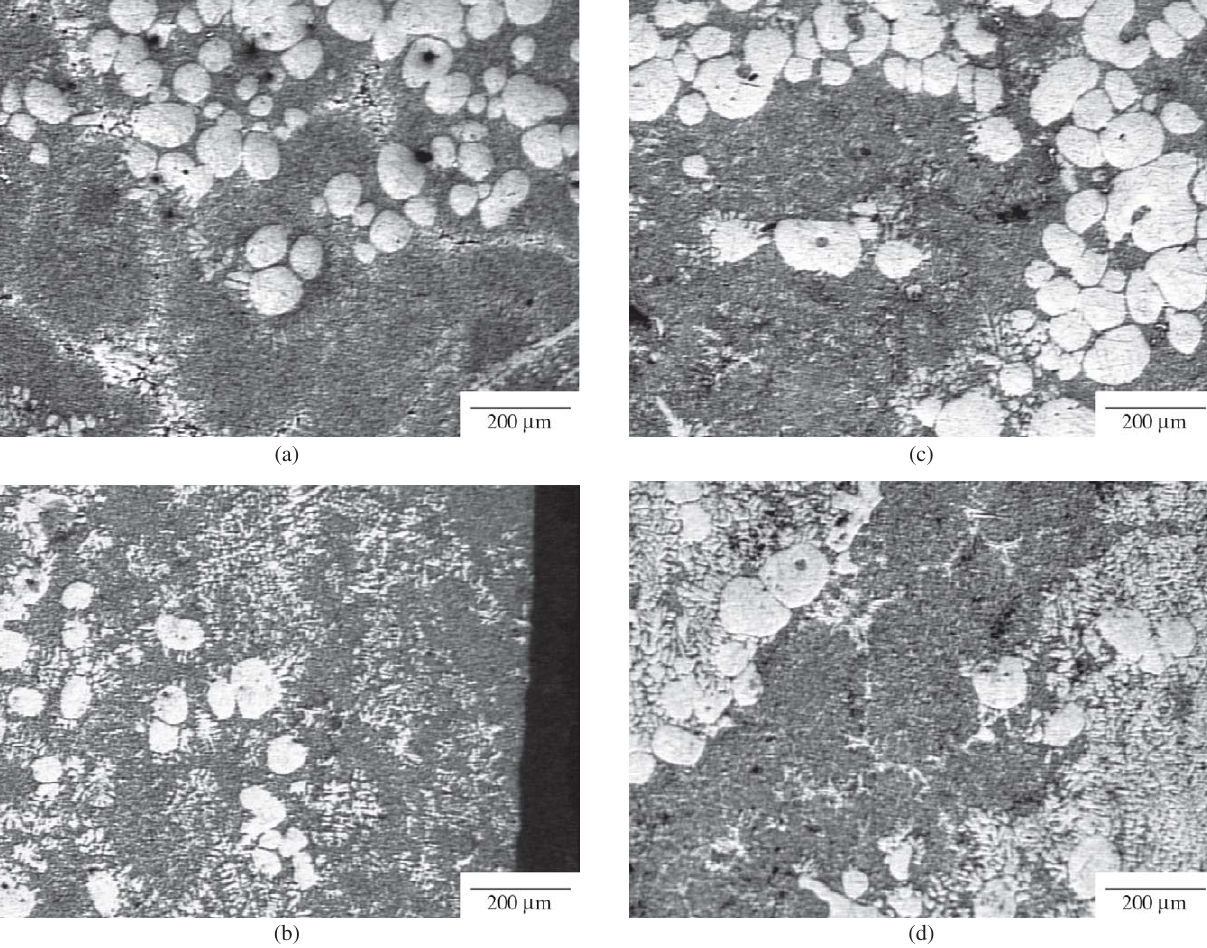
Figure 10. Exemples of solid/liquid distribution in different locations of the thixoextruded rods: a) conical interface between solid/liquid mixture and liquid phase - early stages of the thixoextrusion; b) liquid segregation adjacent to the mould wall; c) liquid pools close to the base of the rod; d) two groups of particles embedded into liquid phase separated by a